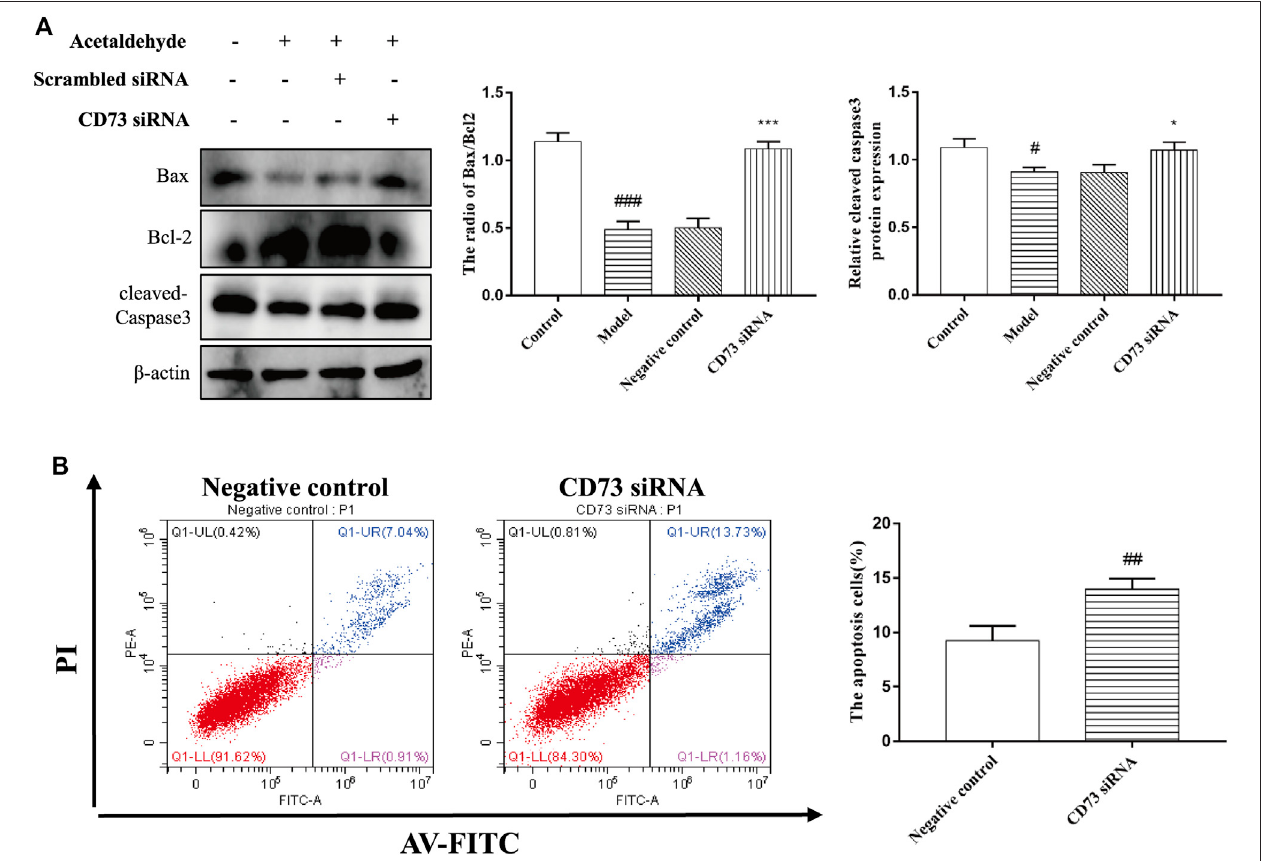
FIGURE 5 | Effectofsilencing CD73 on cell apoptosis in acetaldehyde-induced HSC-T6 cell. (A) Expression of Bax, Bcl-2, and cleaved caspase-3 in HSC-T6 cell. # p < 0.05, ### p < 0.001 vs. control group. *p < 0.05, ***p < 0.001 vs. the negative control group. (B) The apoptosis of HSC-T6 cell was determined by fl ow cytometry. ## p < 0.01 vs. the negative control